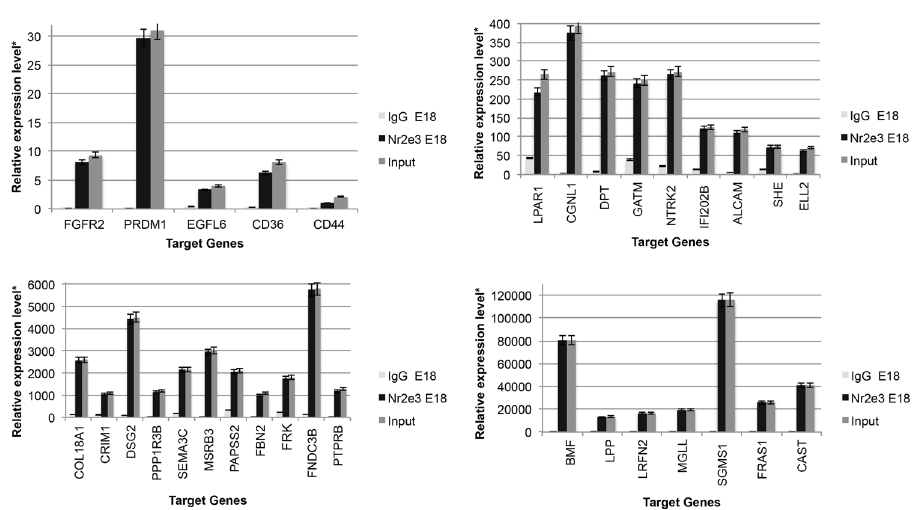
Figure 5. Chromatin IP (chIP) quantitative real time PCR (chIP-qRT-PCR) of gene targets for NR2E3 at E18. Input (positive control), NR2E3-chIP, and immunoglobulin G (IgG) negative control. * Relative expression is calculated as molecules/1000 molecules β -actin. Standard errors are indicated for each gene. All genes had a minimum significance of p <